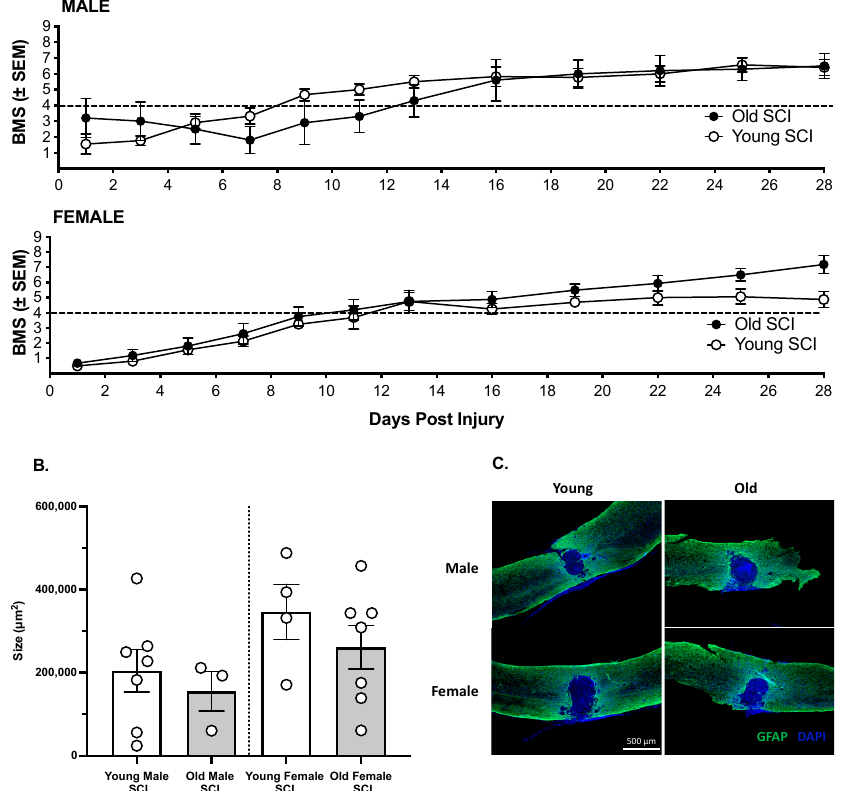
Figure 1. ( A ). Irrespective of age or sex all mice recovered locomotor function, assessed with the BMS scale, over 28 days post injury. There were no significant differences in recovery across groups. The Mean ± SEM for each group is shown across days, and the dashed line represents the score for plantar, weight supported stepping. ( B ). Similarly, age and sex did not affect lesion size at 28 days post injury. The white circles represent individual subjects. ( C ). Representative images of the lesion, visualized with GFAP and DAPI staining, from each demographic are shown. For BBB analyses ( A ), n = 5 old males, 11 young males, 8 old females, 8 young females. For lesion analyses ( B ), n = 3 old males, 6 young males, 7 old females, 4 young